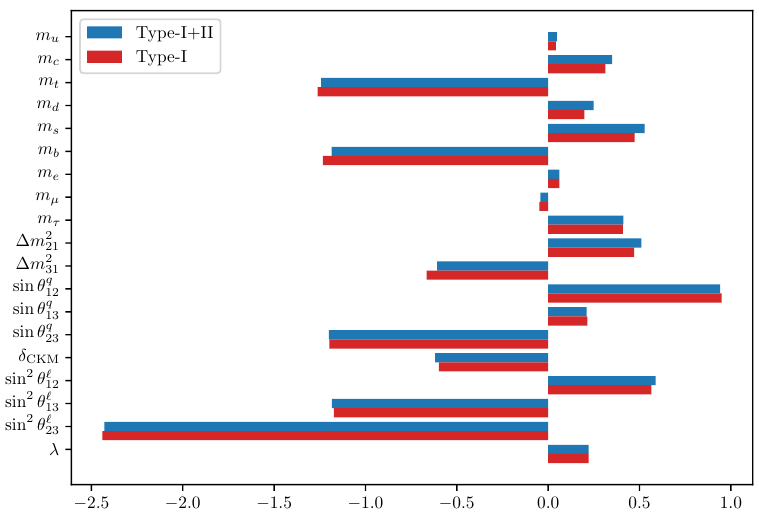
Figure 1 . Pulls corresponding to the SM observables for the two cases of type-I+II seesaw and pure type-I seesaw, respectively, and normal neutrino mass ordering. The sum of the pulls squared gives the (cid:31) 2